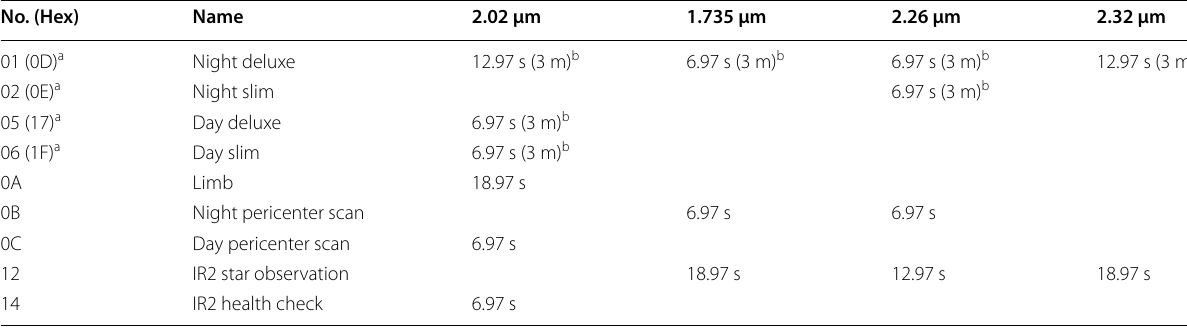
a Numbers in parentheses are the observation programs with “region of interest (ROI)” function enabled b (3 m) indicates the acquired image is the median of 3 images (processed onboard)